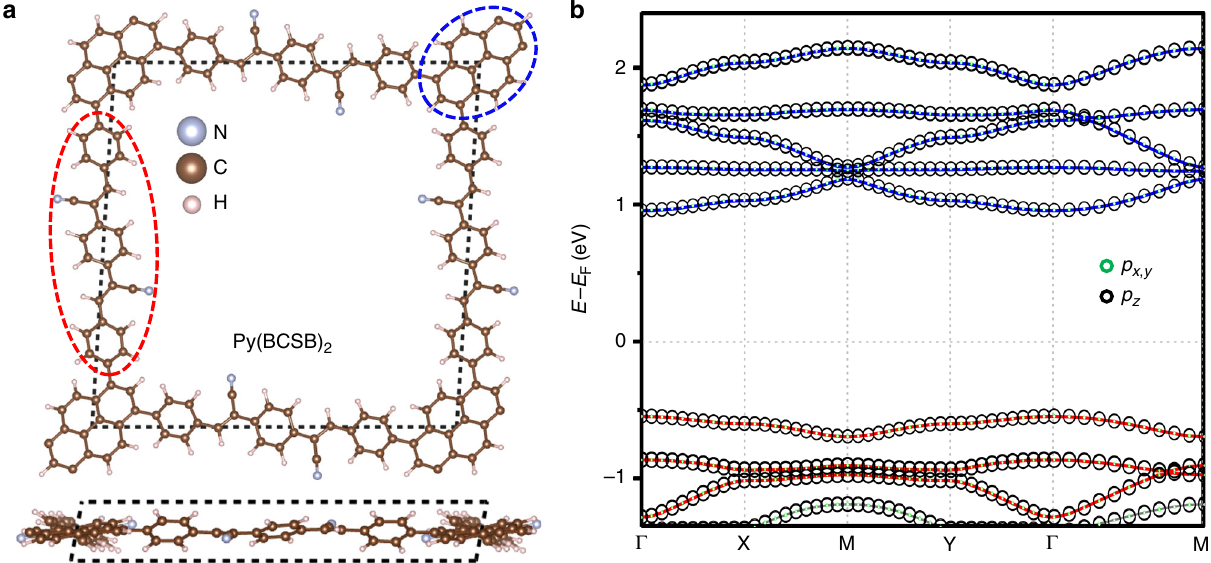
Fig. 2 2D COF Py(BCSB) 2 . a Top and side view of crystal structure of Py(BCSB) 2 with Py (blue ellipse) and BCSB (red ellipse) ligands sitting on the corner and edge-center sites of the distorted Lieb lattice, respectively. b DFT calculated electronic band structure for k z = 0 plane and the orbital-resolved projected band for p z (black circle) and p x ,y (green circle) orbitals. The red and blue bands highlight the Lieb-3 and Lieb-5 band structure,